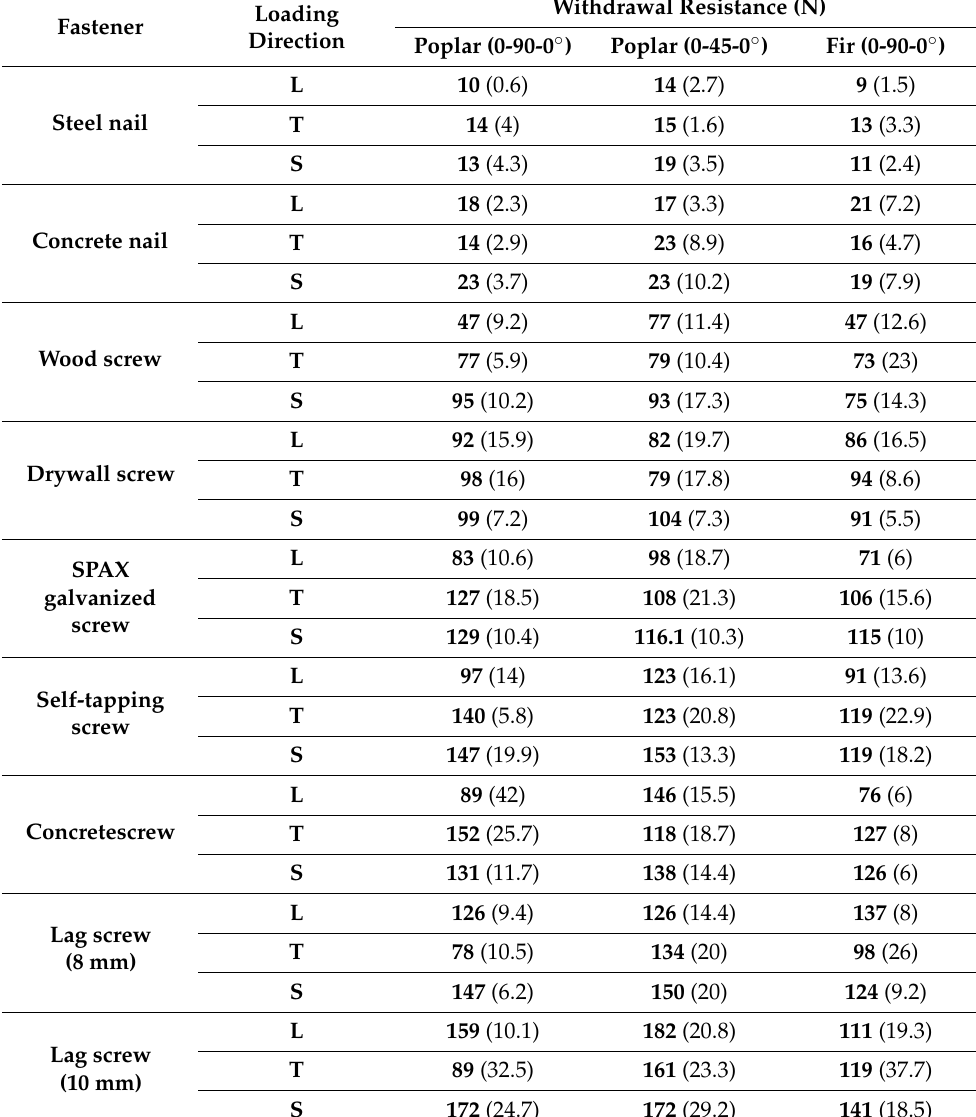
Table 2. Withdrawal resistance of fasteners in all arrangements and loading directions.